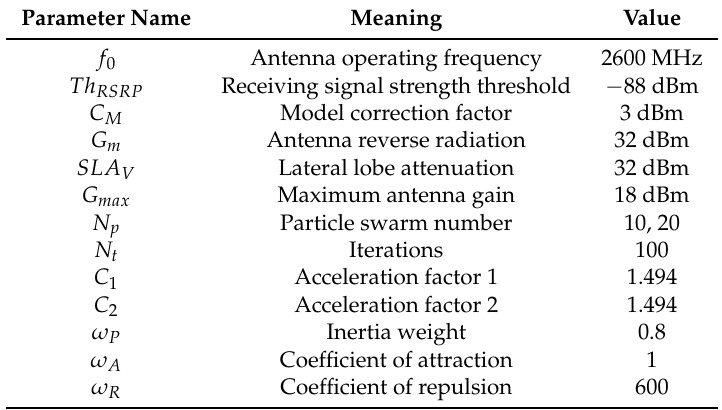
Table 1. Specifications of the parameters of the AVFPSO